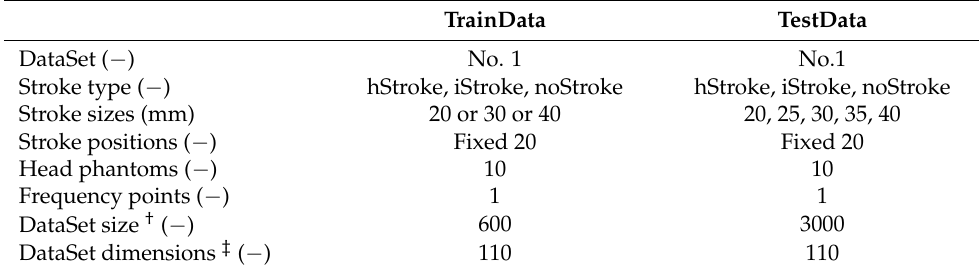
Table 3. Training and testing data parameters for hypothesis